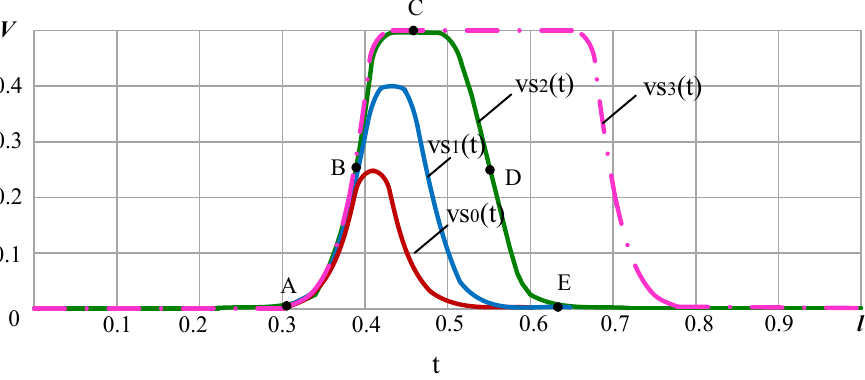
Figure 2. The change of the shape and amplitude of a video signal with the change of the light zone width.